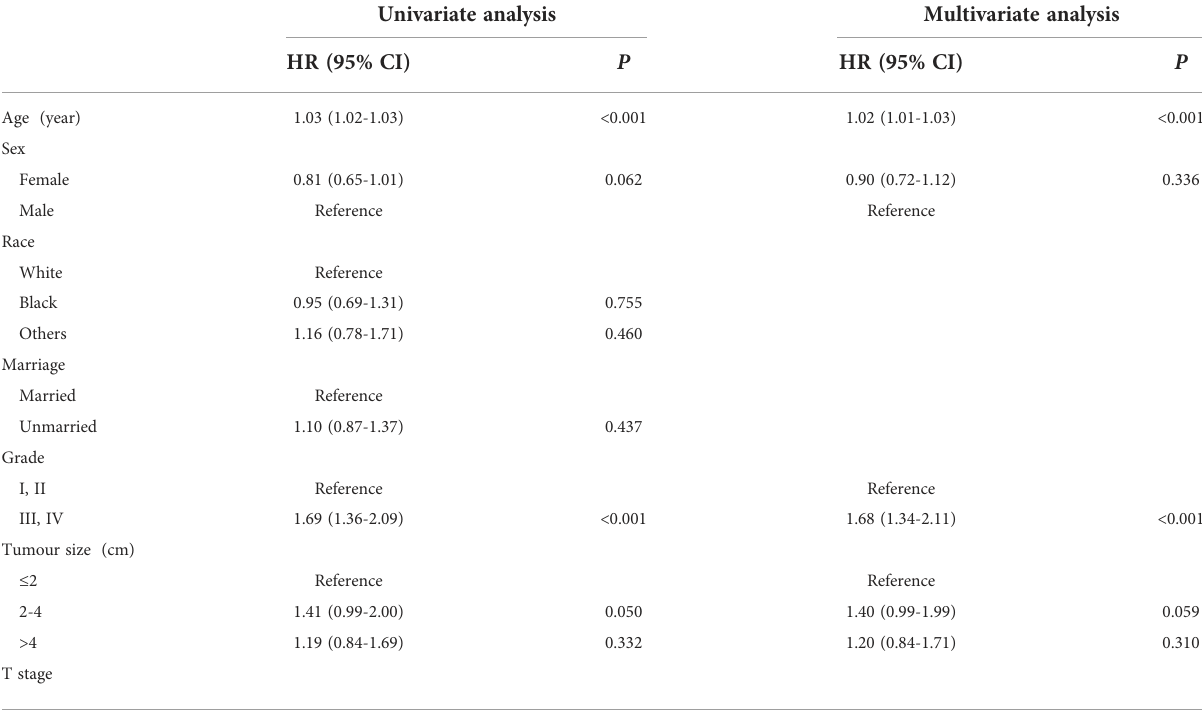
TABLE 3 Univariate and multivariate analysis of cancer-speci fi c survival (CSS) in the training set. Univariate analysis Multivariate